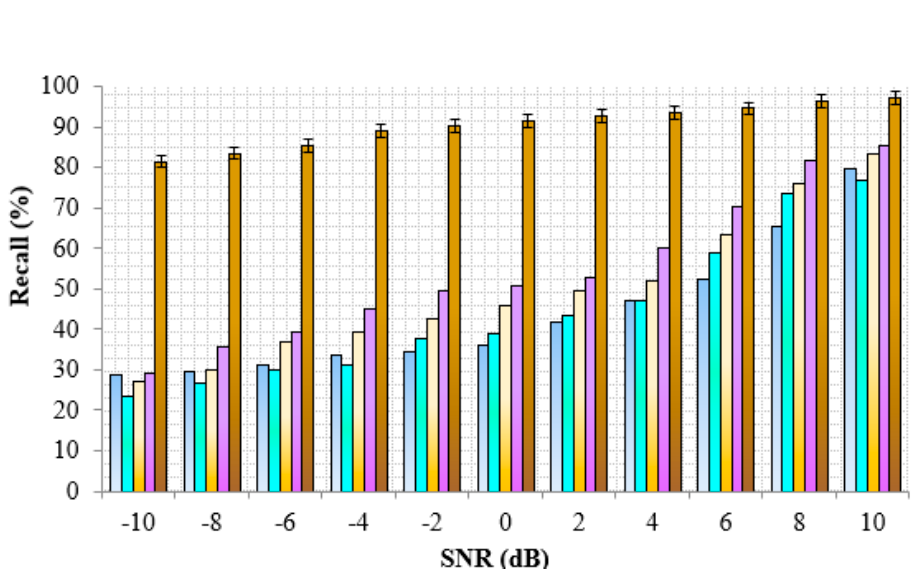
Figure 15. Comparison recall (Scenario 1).